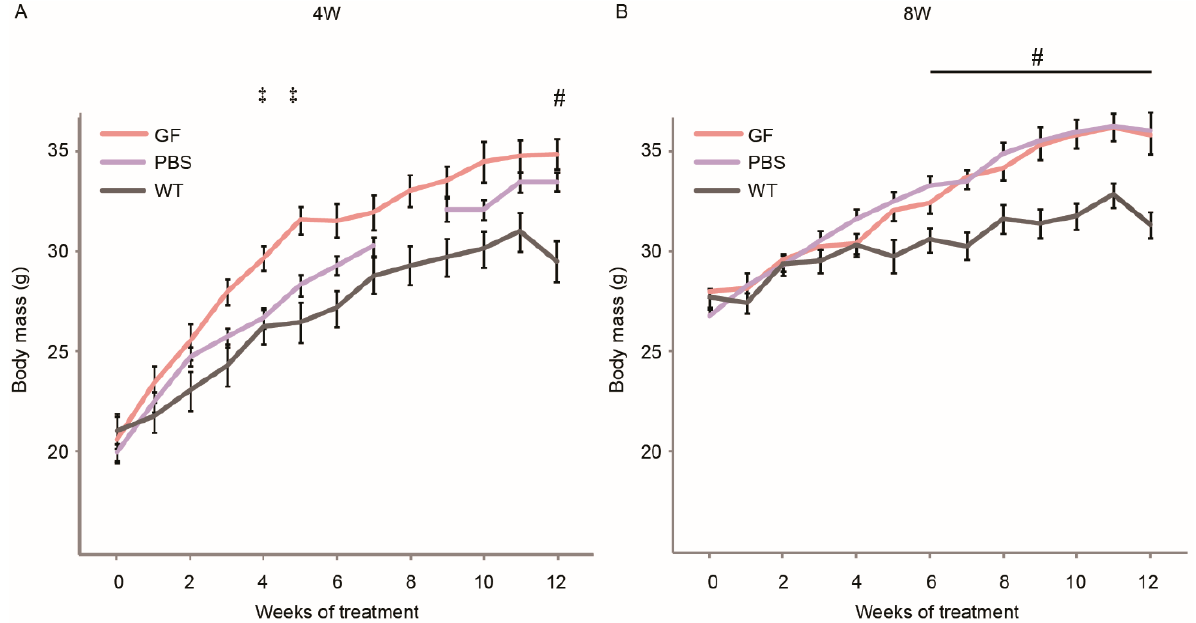
Figure 1. Growth curves of the different treatment cohorts . The growth pattern of the six groups in the 4W cohort ( A ) and the 8W cohort ( B ). Lack of data point in 4W PBS is due to accidental loss of measurements. GF, growth factor; PBS, phosphate-buffered saline; WT, wild-type strain. Vertical bars are SEM. Two-way ANOVAs were performed with subsequent Tukey HSD post-hoc tests to assess significance. Symbols indicate p < 0.05: ‡; GF vs. PBS, #; PBS vs. WT. The number N of each group was 12.